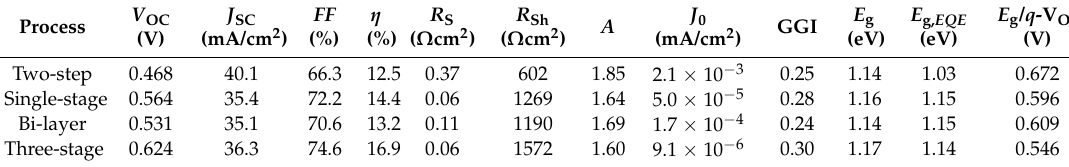
Table 3. Performance parameters, diode parameters, GGI ratios, bandgap energies ( E g and E g , EQE